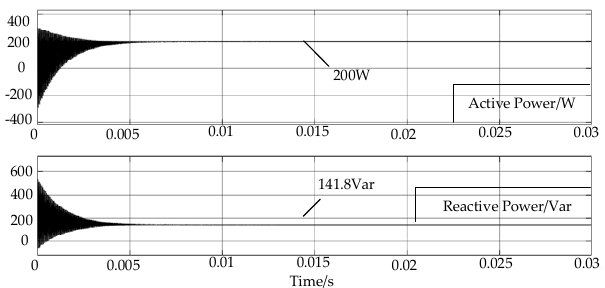
Figure 26. φ AD = 92° and φ AB = 239° active power and reactive power waveforms. Observe the ZVS of each bridge arm as shown in Figures 27–29 below.